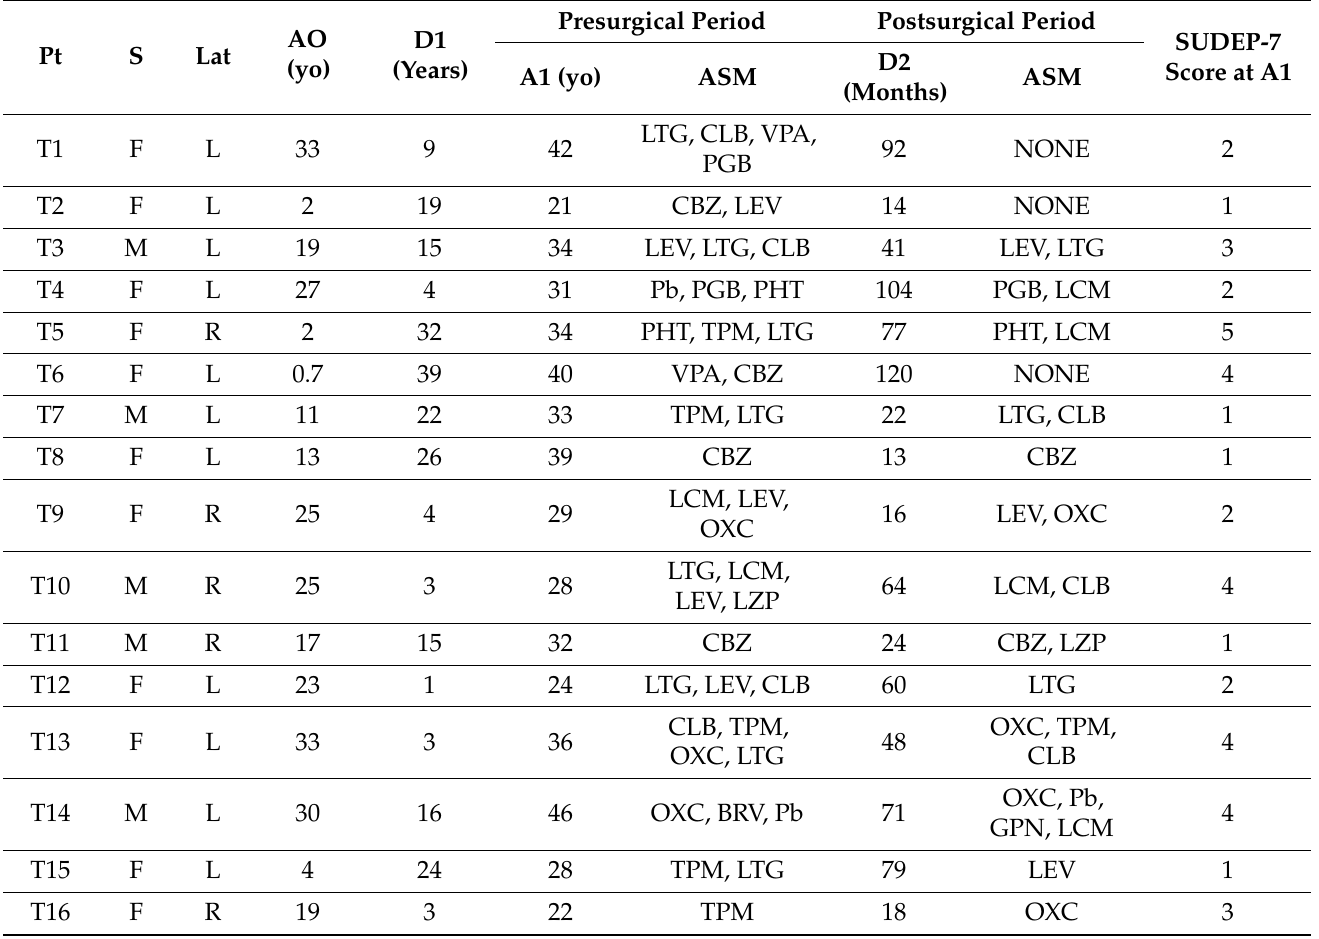
Table 2. Summary of presurgical and postsurgical features of TLE patients.